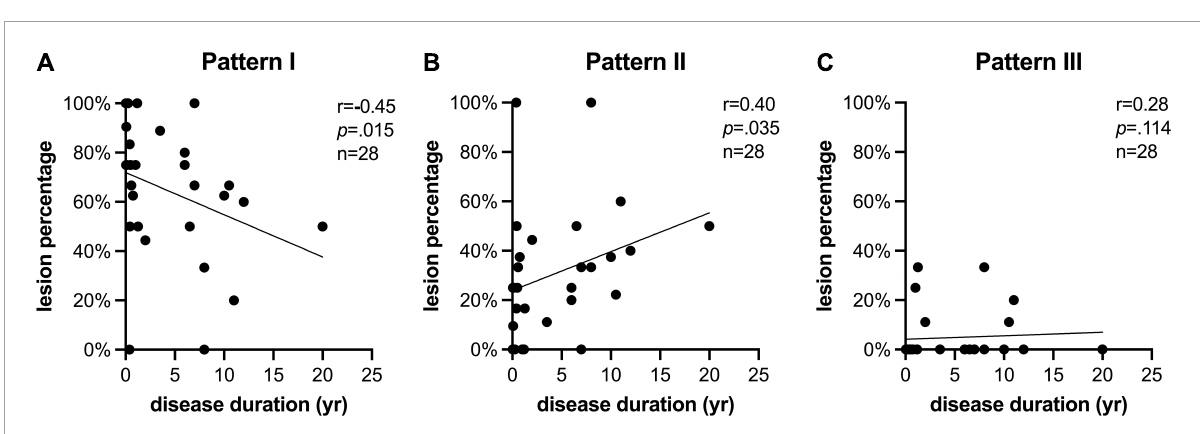
FIGURE5 k ex multimodal MRI pattern is related to disease duration. The percentage of lesions identified as (A) Pattern I (which are k ex + and QSM + ); (B) Pattern II (which are either k ex + and QSM – , or k ex – and QSM + ); and (C) Pattern III (which are k ex – and QSM – ) changed with the disease duration of the case. Cases with long disease duration showed smaller percentage of Pattern I but larger percentage of Patten II in Gd – lesions than cases with short disease duration.